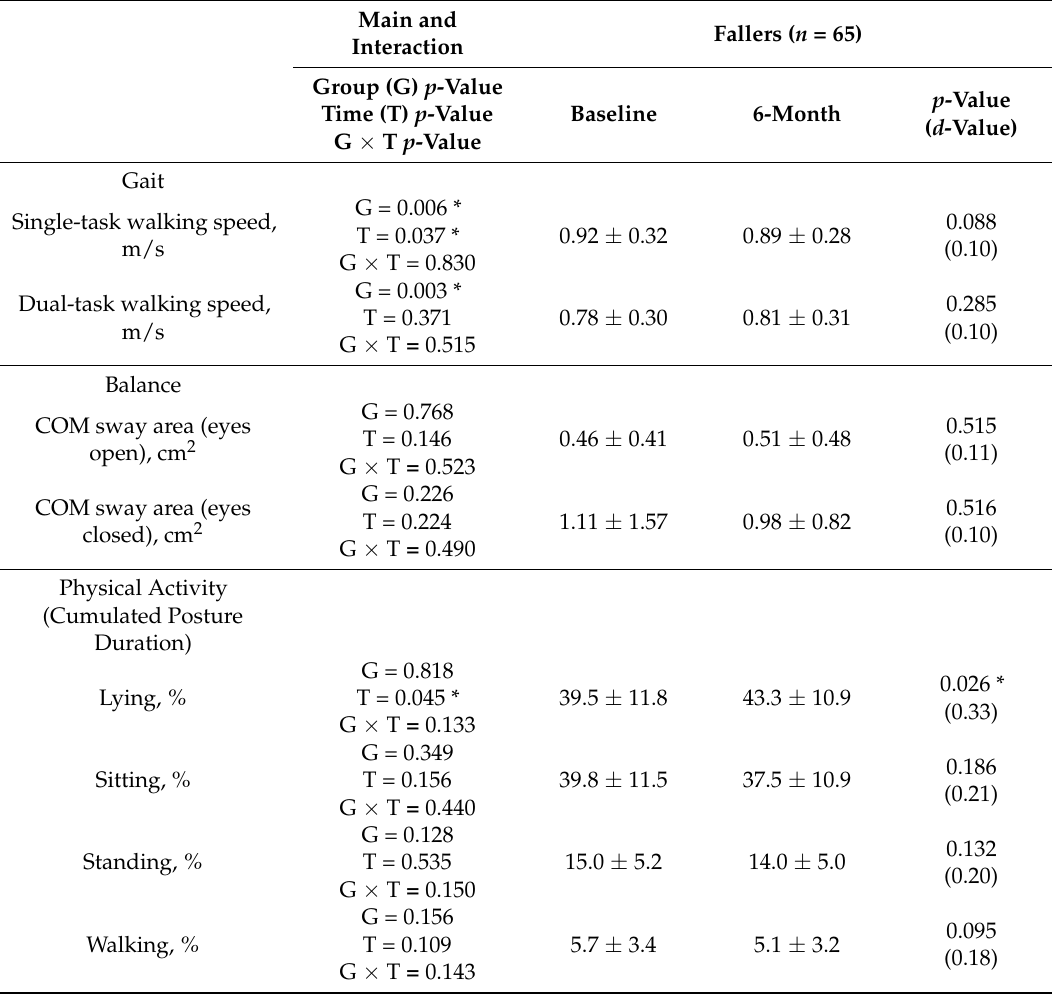
Table 3. Main and interaction effects and comparison of gait, balance, and physical activity variables as a function of the assessment time (baseline and 6-month) and group (fallers and